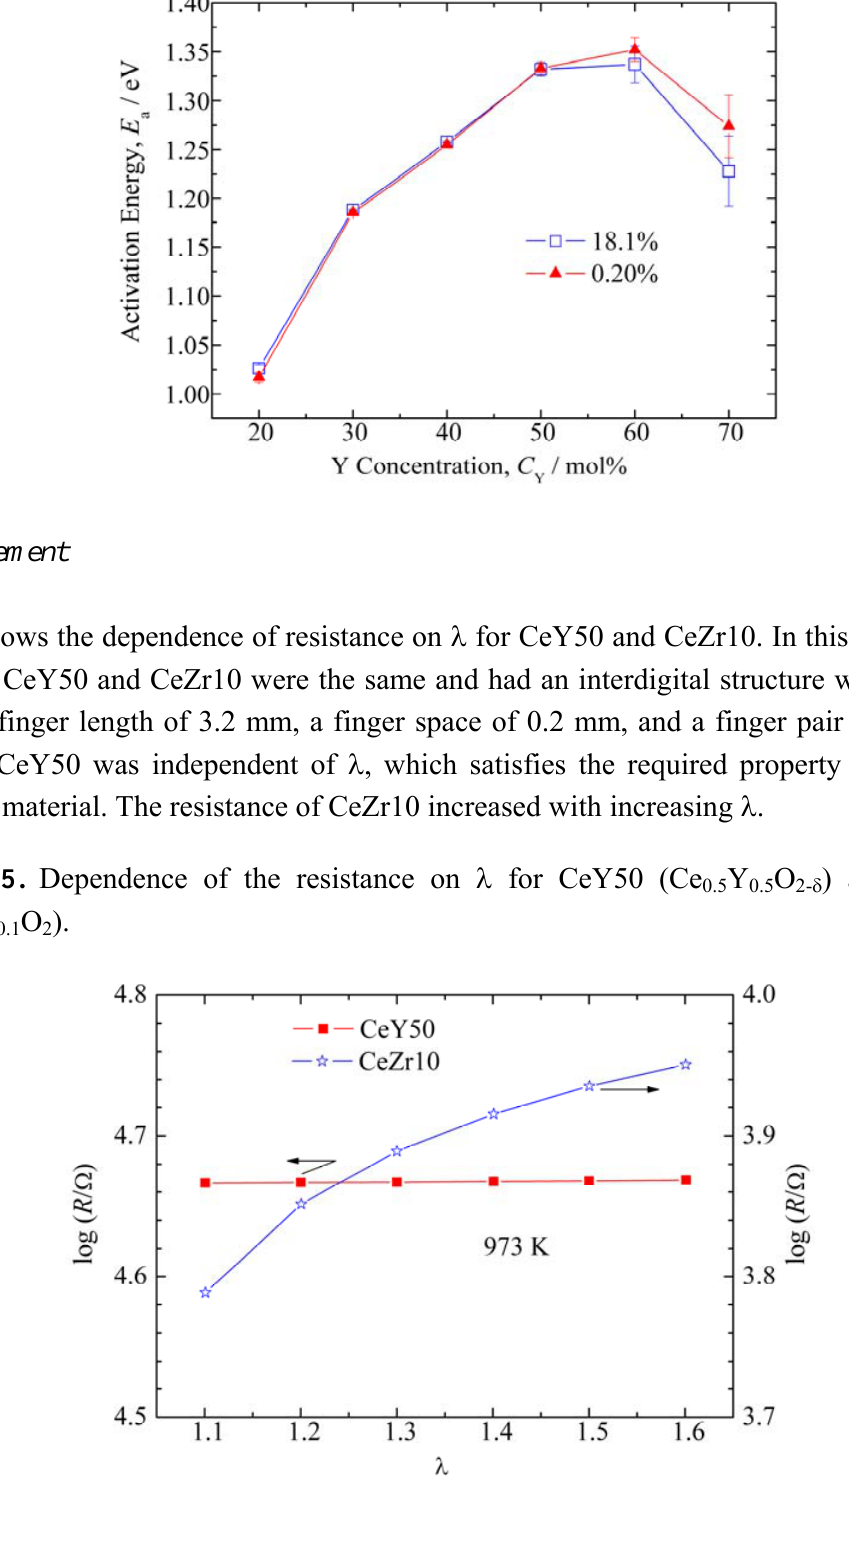
Figure 4. Dependence of activation energy on the Y concentration, calculated from the data shown in Figure 3.